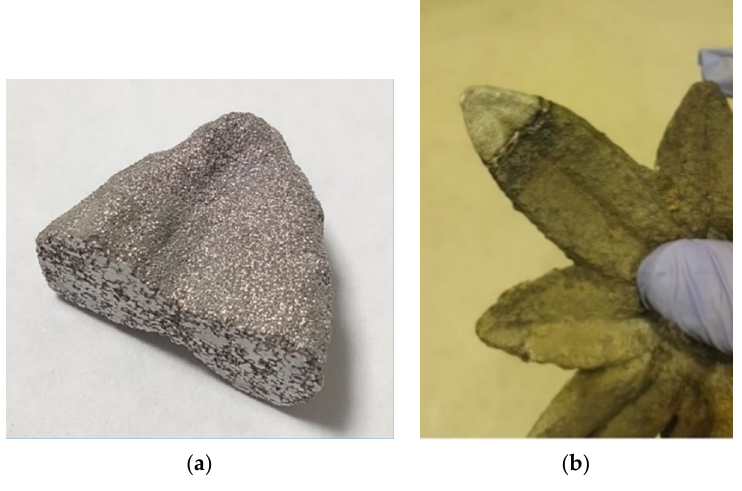
Figure 7. ( a )—DMLS printed star ray; ( b )—welded star ray.